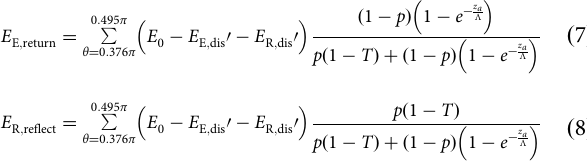
0 and E 0 E ; dis R ; dis